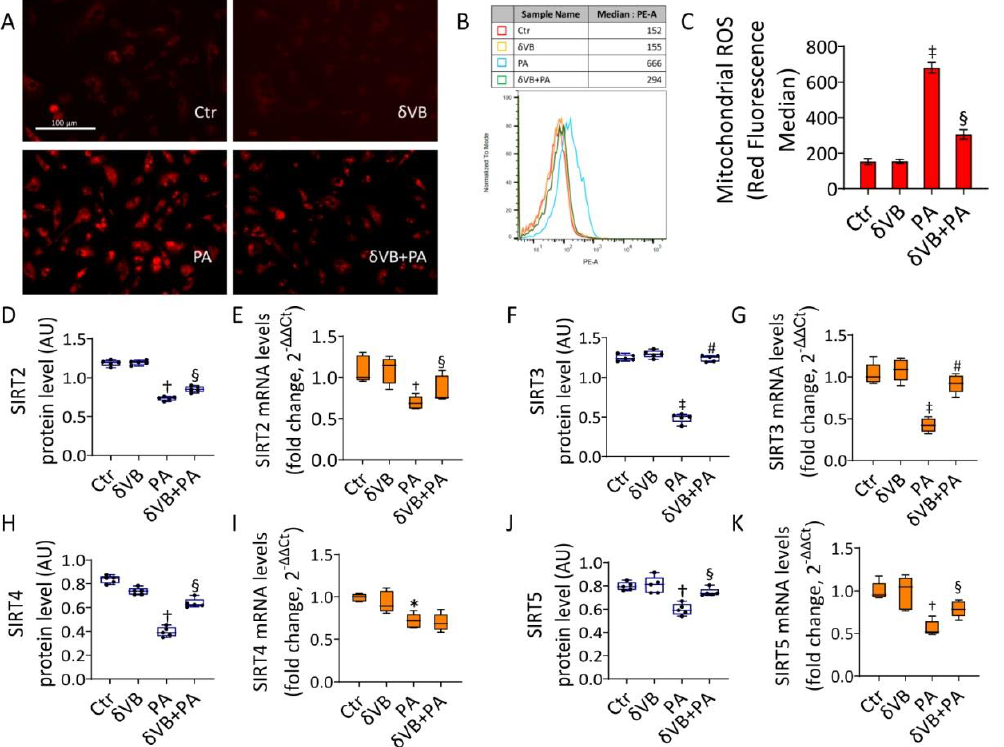
Figure 7. δ VB reduced the PA-induced mitochondrial dysfunction. ( A ) Representative images by fluorescence microscopy (scale bars = 100 µ m) and ( B , C ) FACS analysis of mitochondrial ROS detection (MFI). Levels of mRNA and immunoblotting analysis of ( D , E ) SIRT2, ( F , G ) SIRT3, ( H , I ) SIRT4, and ( J , K ) SIRT5 in EC exposed for 48 h to 0.5 mM δ VB, 0.5 mM PA (PA), or pretreated for 16 h with δ VB before 48 h PA treatment ( δ VB+PA). Control cells (Ctr) were treated with the corresponding highest volume of HBSS-10 mM Hepes. Western blotting results ( n = 5) are expressed as arbitrary units (AU). mRNA levels are reported as floating bars with line representing the median ± SD ( n = 3). * p < 0.05 vs. Ctr; † p < 0.01 vs. Ctr; ‡ p < 0.001 vs. Ctr; § p < 0.05 vs. PA; # p < 0.01 vs. PA.